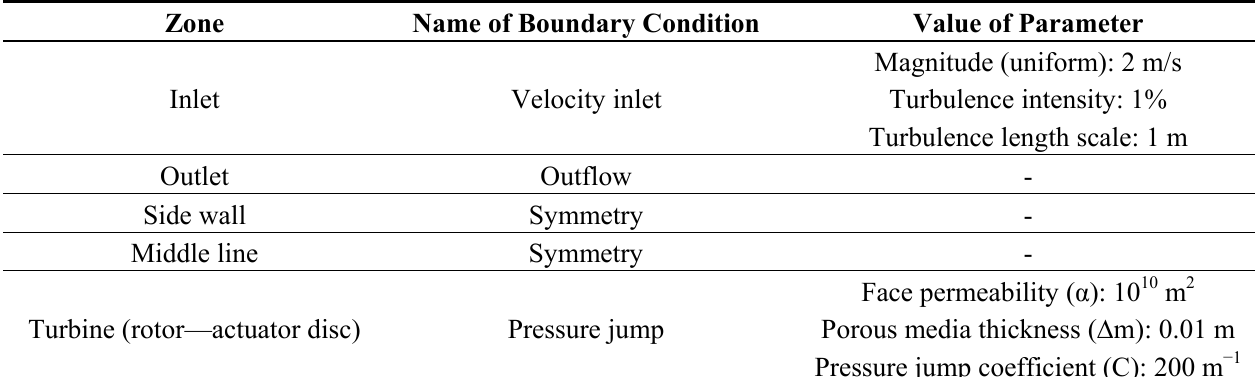
Table 1. Settings of CFD simulation.